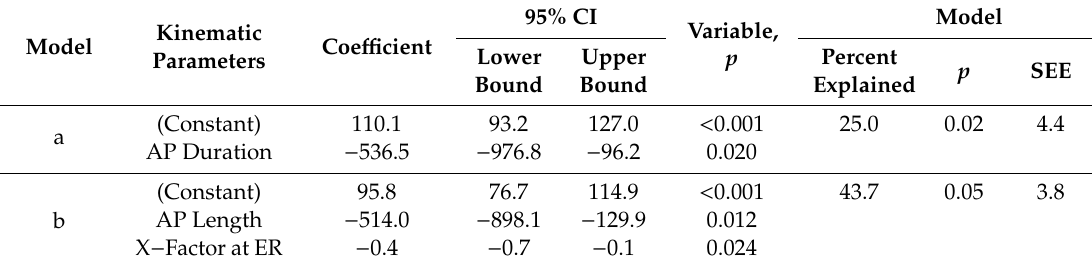
Table 5. Multiple regression equations explaining variance in shuttlecock speed.